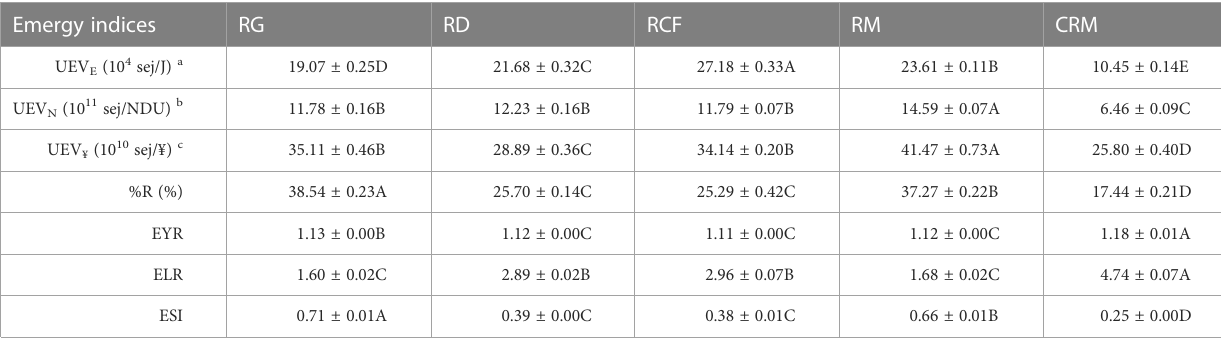
TABLE 5 Comparison of emergy indices for the fi ve rice production modes.